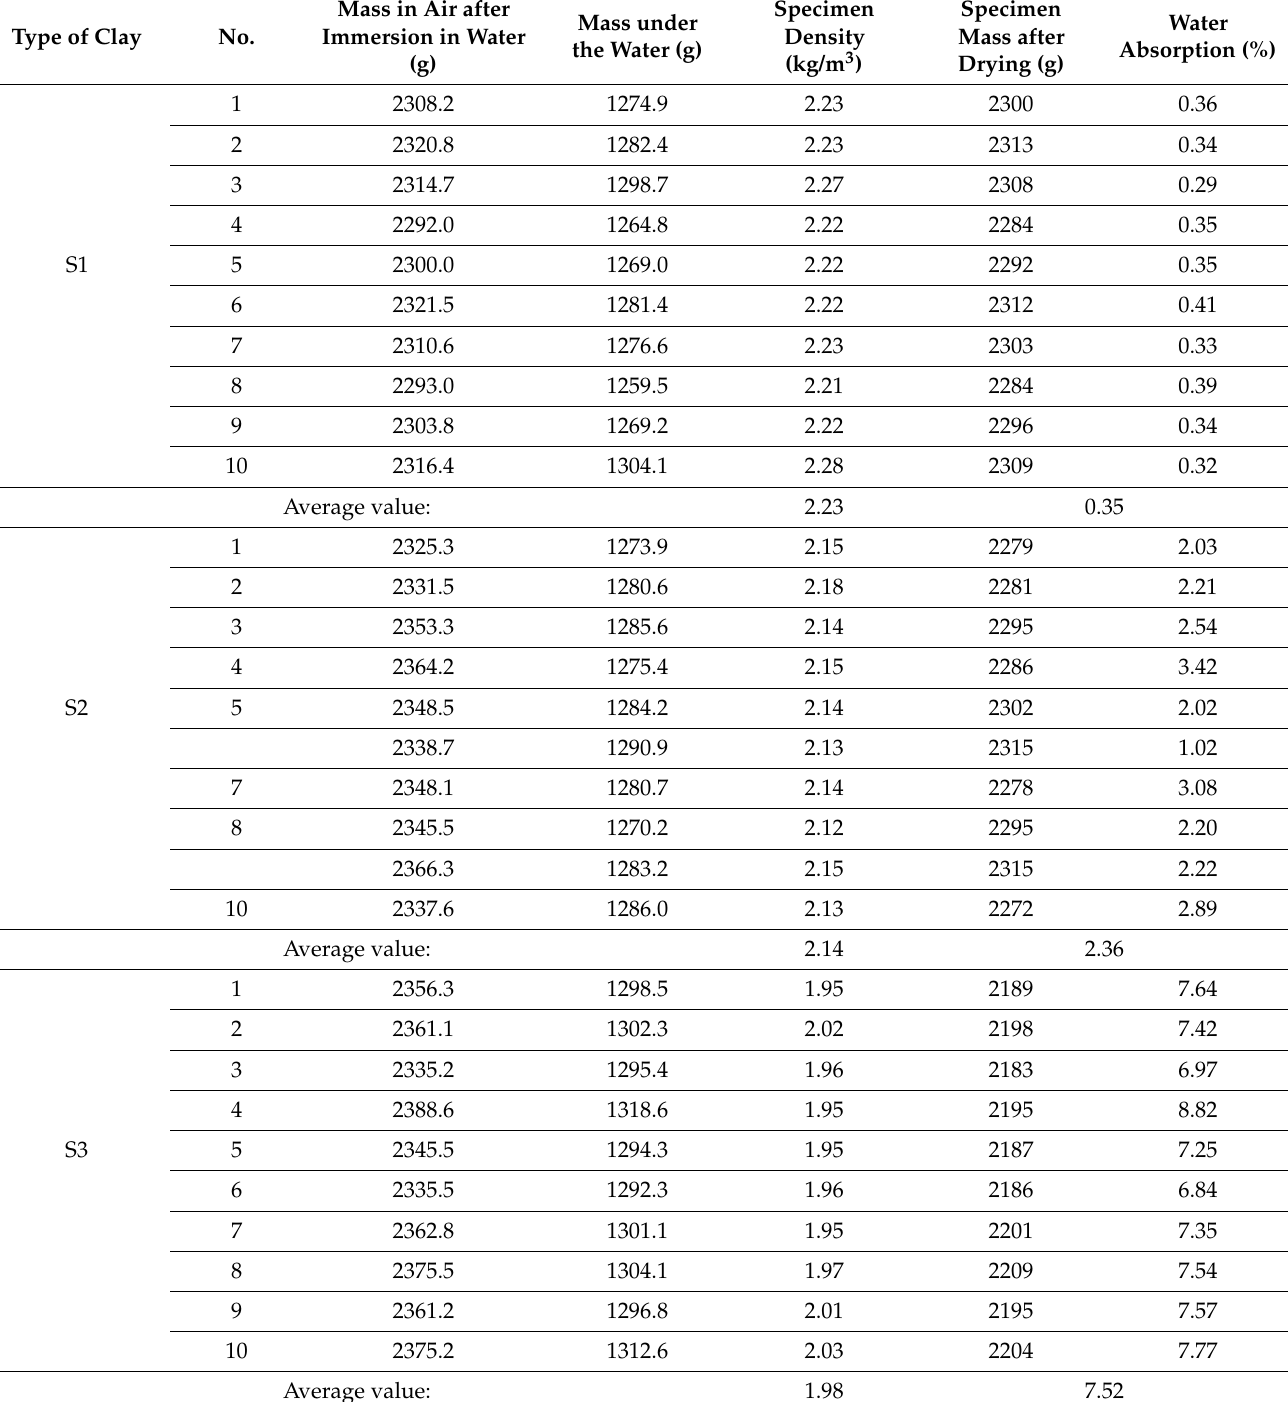
Table 4. Determination of water